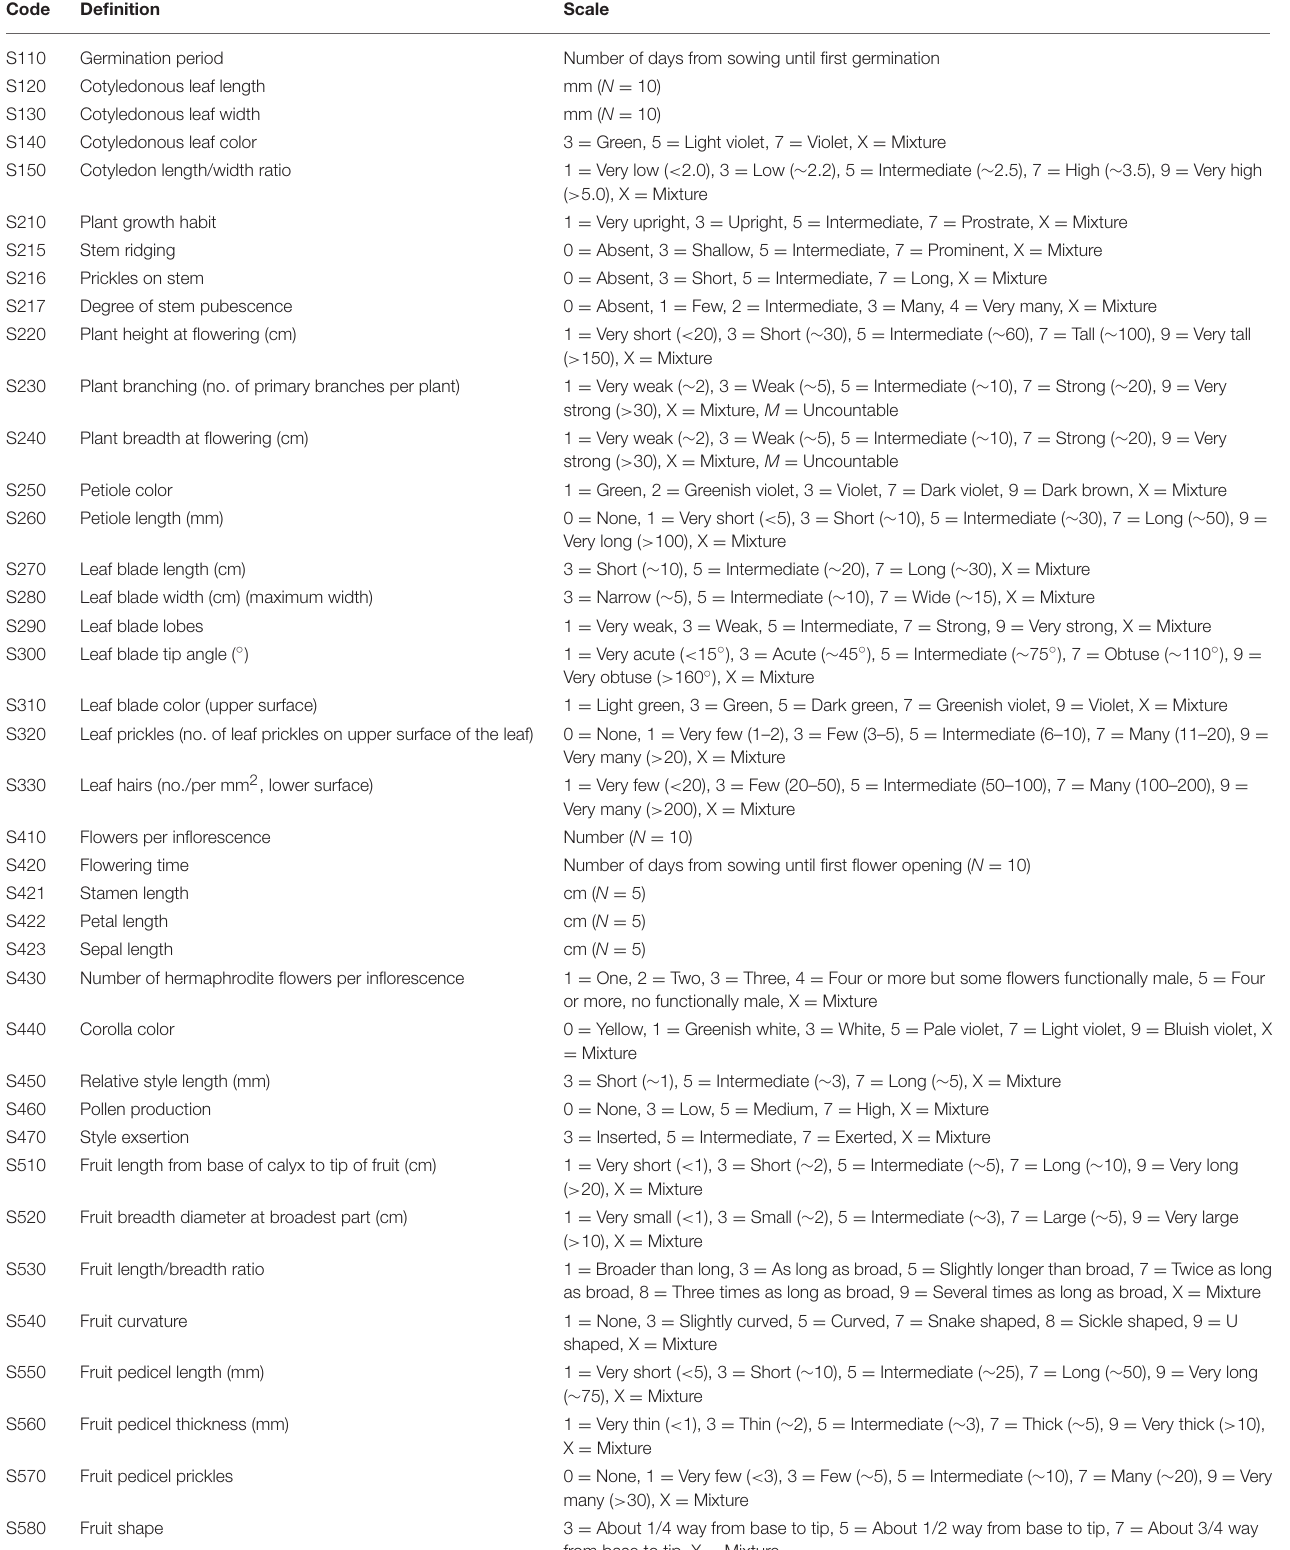
TABLE 5 | A complete list of standard descriptors for eggplants used at the World Vegetable Center (AVGRIS,